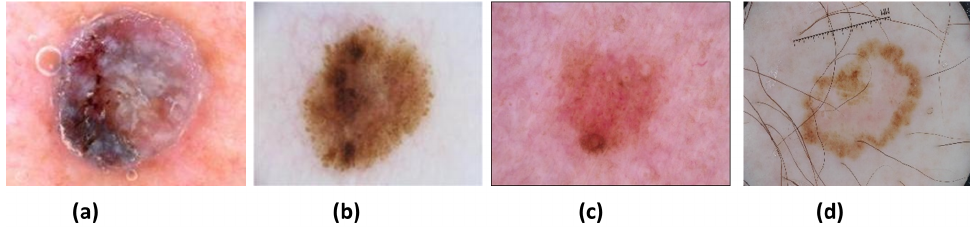
Figure 1. Different types of skin lesions: ( a ) MEL, ( b ) BEN, ( c ) NV, and ( d )